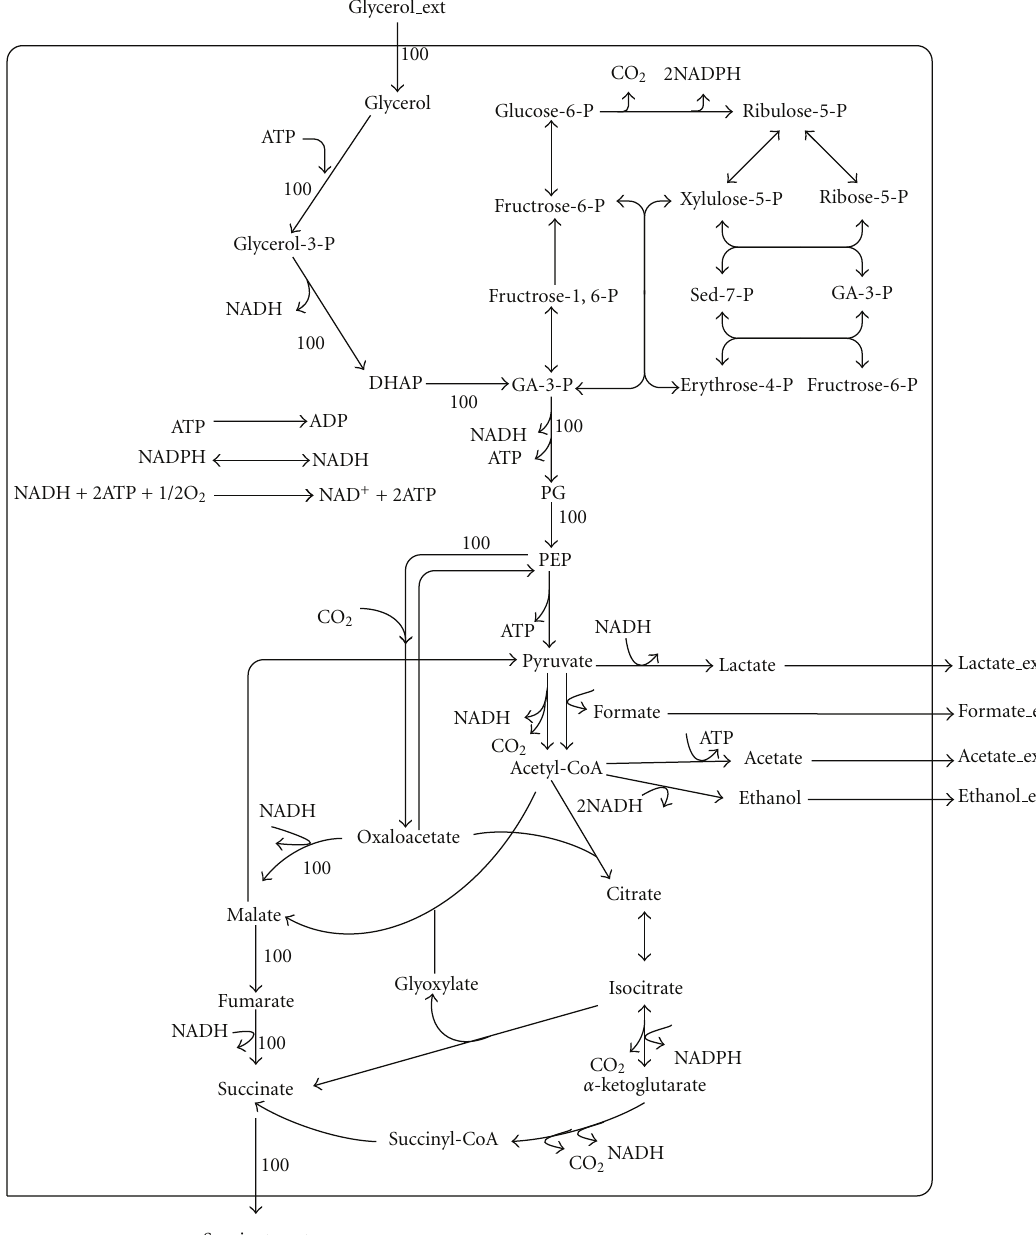
Figure 6: The optimum flux distribution of glycerol metabolism for succinate production in E. coli under aerobic conditions.